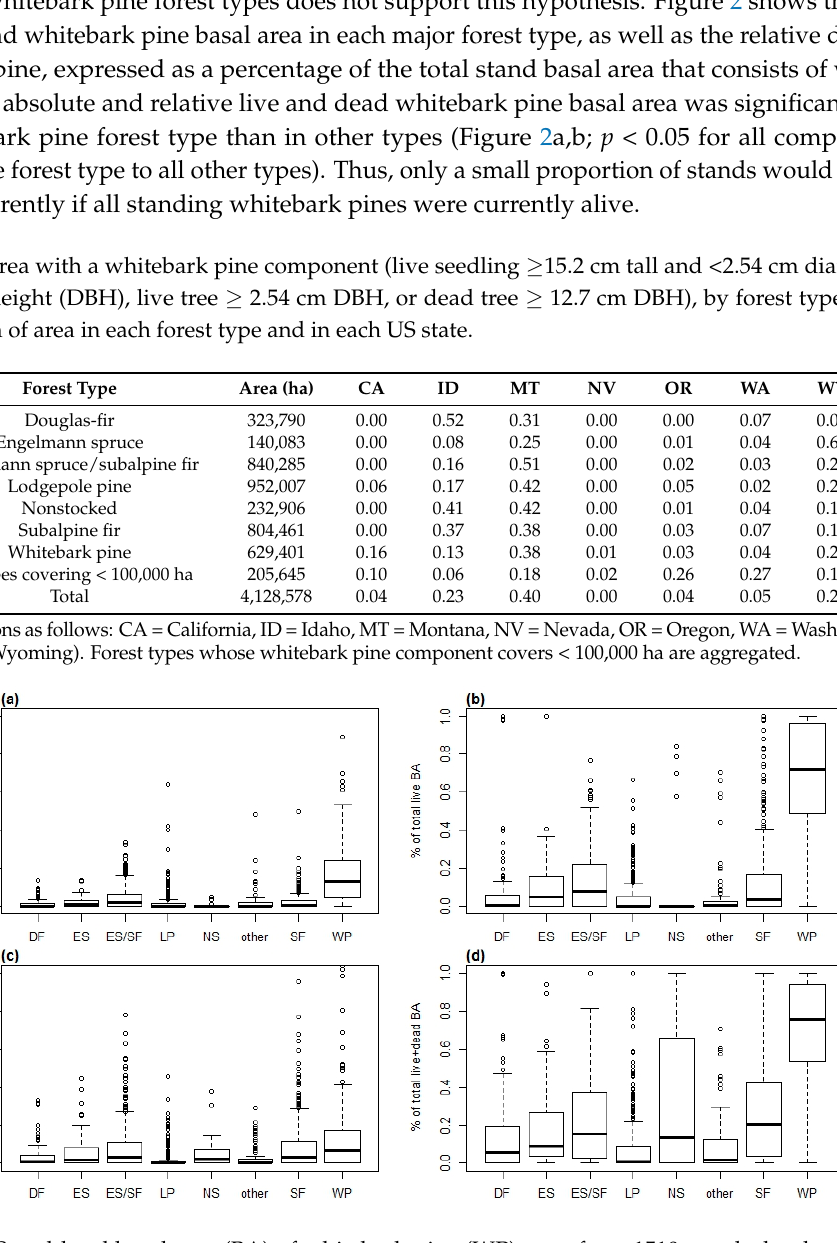
Figure 2. Stand-level basal area (BA) of whitebark pine (WP) trees from 1510 stands, by dominant forest type: ( a ) basal area of live whitebark pine trees; ( b ) basal area of live whitebark pine trees as a percentage of basal area of all live trees; ( c ) basal area of dead whitebark pine trees; and ( d ) basal area of live and dead whitebark pine trees as a percentage of basal area of all trees. Forest types are abbreviated as follows: DF = Douglas-fir ( n = 120), ES = Engelmann spruce ( n = 47), ES/SF = Engelmann spruce/subalpine fir ( n = 313), LP = lodgepole pine ( n = 362), NS = nonstocked ( n = 34), other = aggregate of all types represented by <30 plots each ( n = 75), SF = subalpine fir ( n = 343), and WP = whitebark pine ( n = 216). Horizontal lines within boxes represent medians. Upper and lower box boundaries represent 1st and 3rd quartiles (25th and 75th percentiles, respectively). Horizontal lines at ends of vertical dashed lines represent 1.5× the interquartile range, and circles represent plots beyond 1.5× the interquartile range.